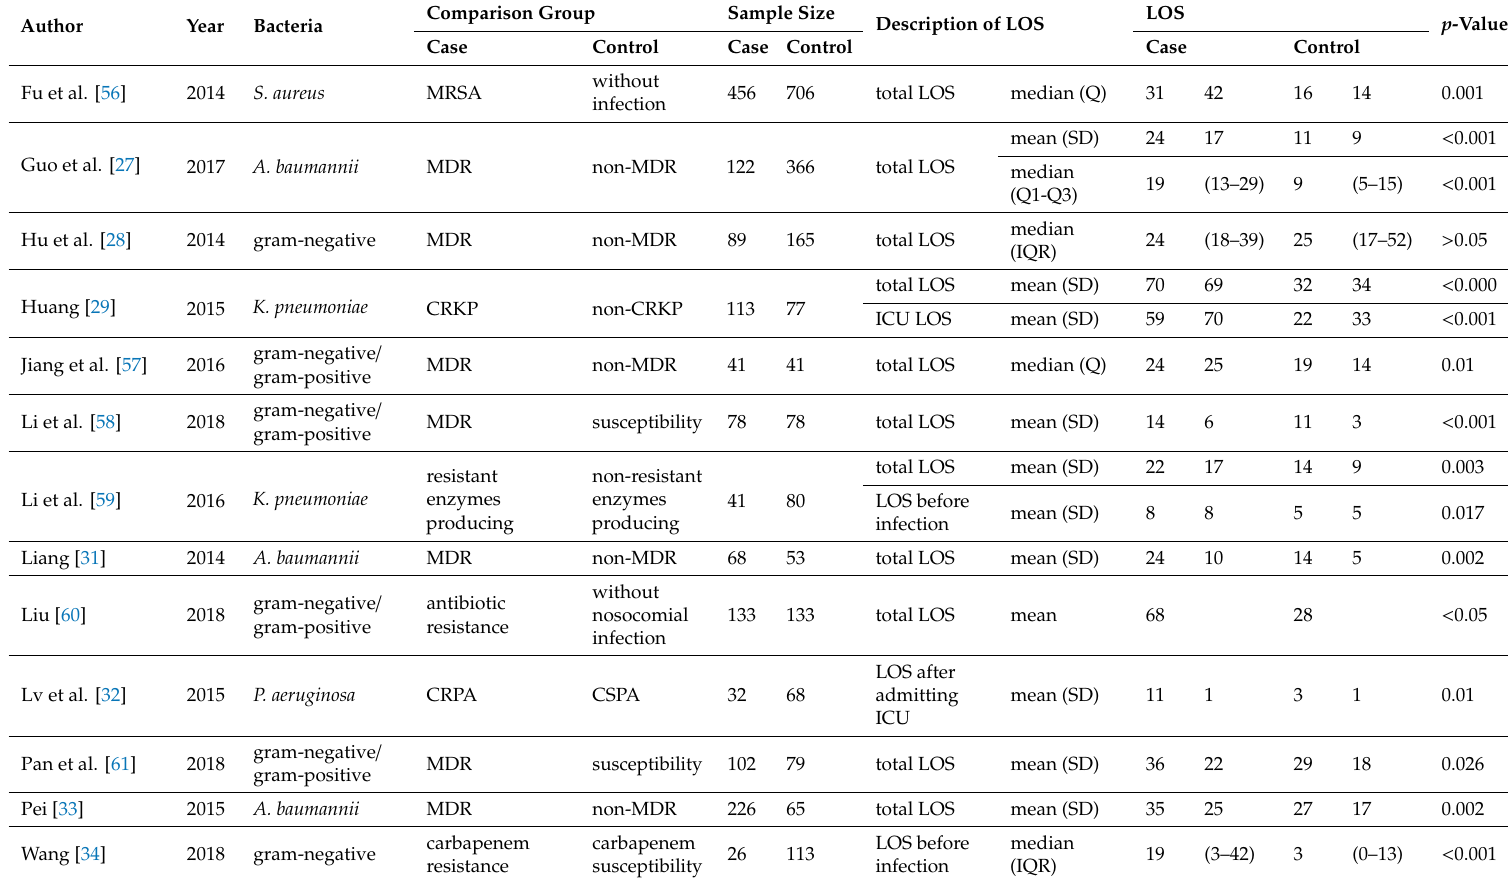
Table 2. Studies describing hospital stay among patients with antibiotic resistance and multi-drug